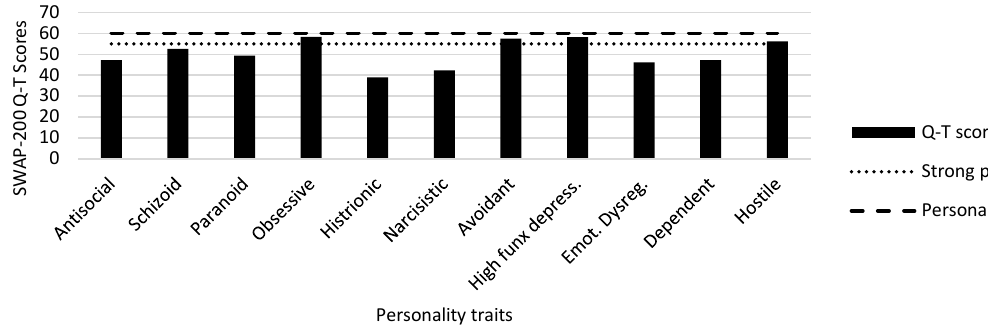
Figure 6: Margherita’s SWAP-200 Session 1 Q-T score